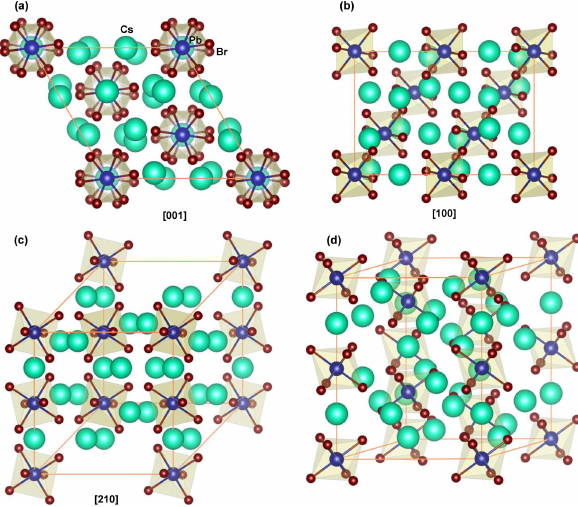
Figure 28: Structural models of Cs 4 PbBr 6 with 0-dimensional per- ovskite structures, observed along (a) [001], (b) [100], and (c) [210]. (d) Perspective view of the structure.